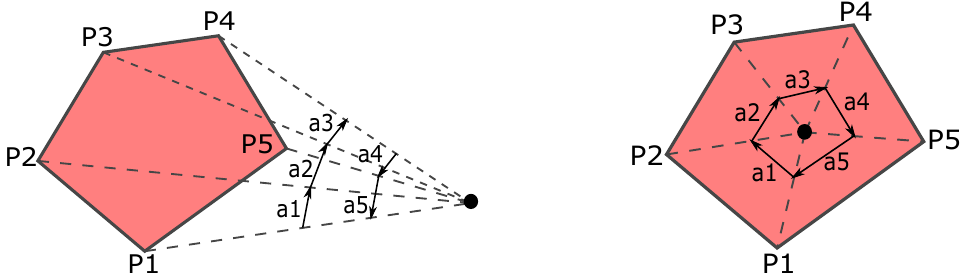
Figure 7. The signed angle method is used to evaluate whether a tested waypoint (black dot) is inside or outside a polygonal geofence. ( Left ), an example where the angles of an external waypoint sum up to 0 ◦ . ( Right ), an interior waypoint whose angles sum up to 360 ◦ .